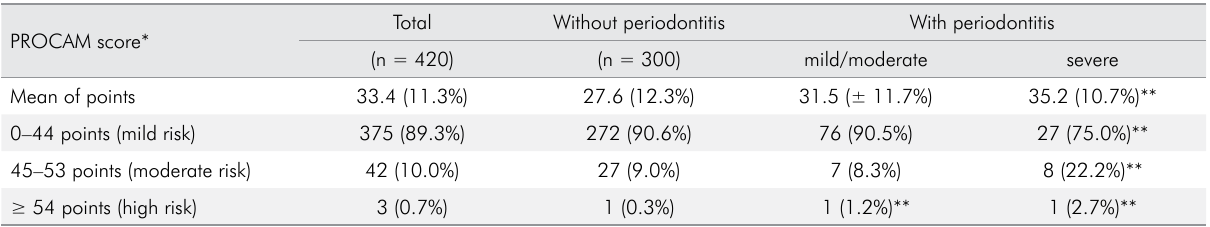
Table 5. Coronary risk profile, defined by PROCAM Score, according to the presence of periodontitis. Advento study. Sao Paulo,